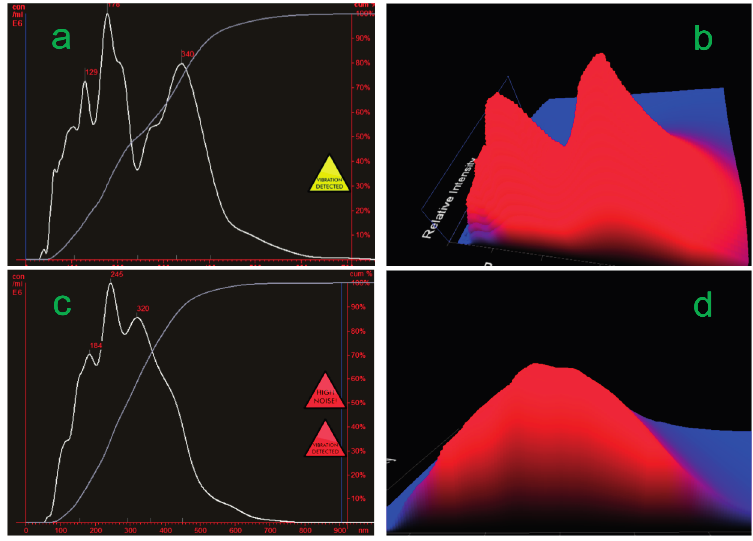
Figure 3. Graphs of particle size/concentration and particle size/relative intensity 3D plot of F-2 and F-3. ( a , b ) display the particle size distribution of F-2; while ( c , d ) display